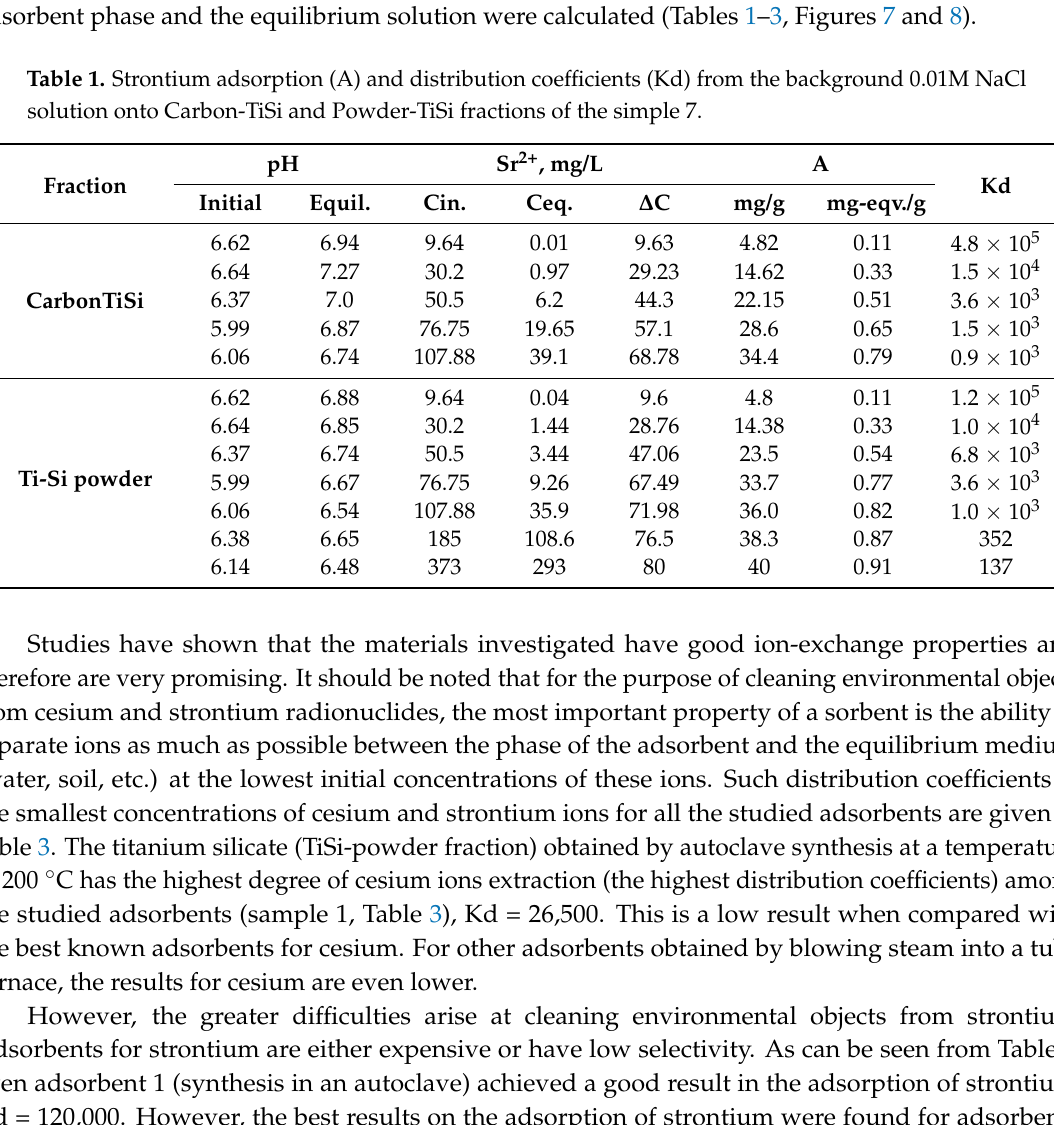
Table 1. Strontium adsorption (A) and distribution coefficients (Kd) from the background 0.01M NaCl solution onto Carbon-TiSi and Powder-TiSi fractions of the simple 7. pH Sr 2+ , mg/L A Fraction Initial Equil. Cin. Ceq. ∆ C